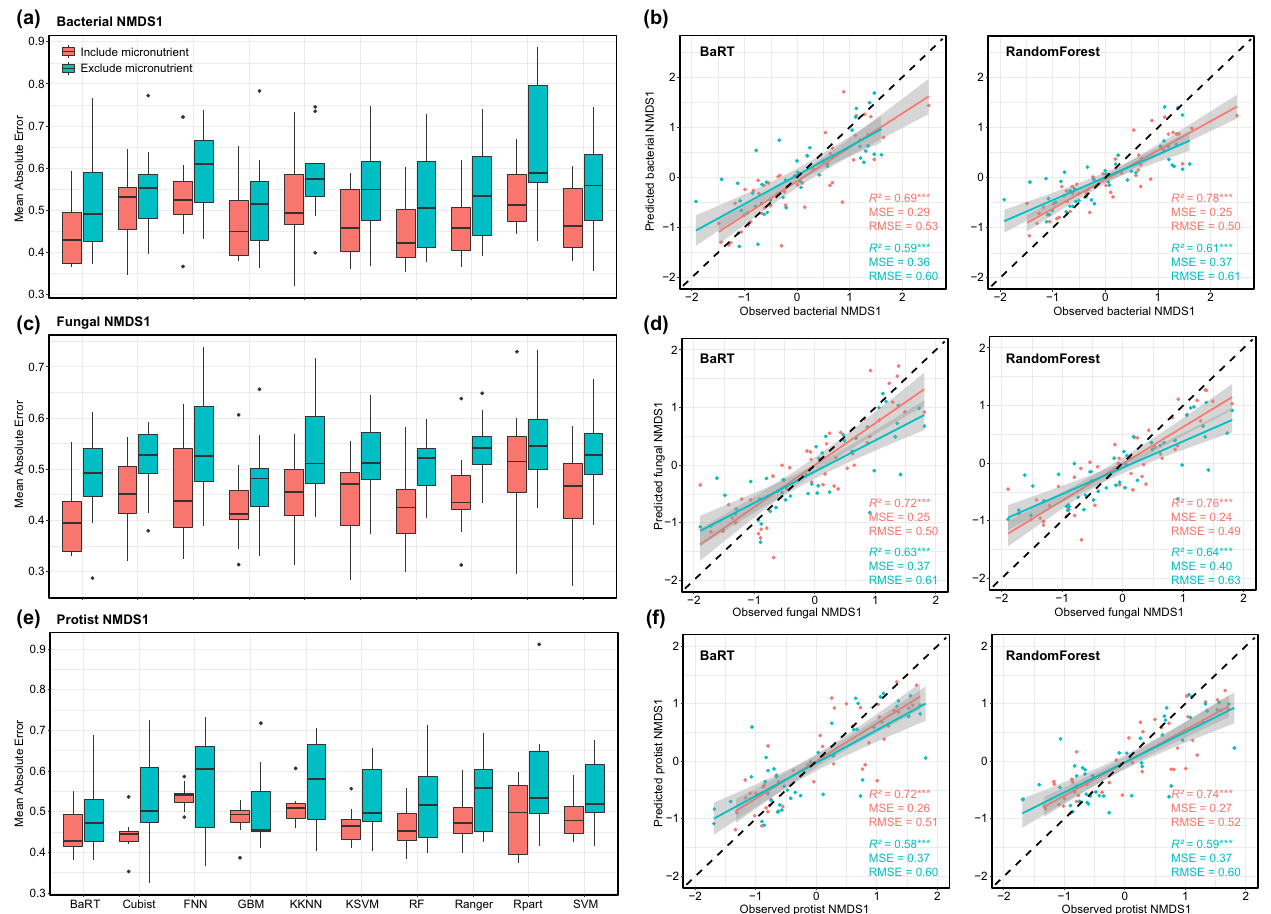
Fig. 5 Comparison of prediction errors of different machine learning algorithms for the structure of bacterial, fungal and protistan communities. Machine learning algorithms include Bagged Regression Tree (BaRT), Cubist, Fast Nearest Neighbor (FNN), Gradient Boosting Machines (GBM), Weighted k-Nearest Neighbor (KKNN), Kernel Support Vector Machine (KSVM), Random Forest (RF), Ranger, Rpart and Support Vector Machine (SVM), showing bacterial ( a ), fungal ( c ), and protistan communities ( e ). The center line of boxplot represents the median of data. The boxplot bounds the interquartile range (IQR) divided by the median, and whiskers extend to a maximum of 1.5 times the IQR beyond the box. Other observed data points outside the boundary of the whiskers are plotted as outliers, shown a dot. Predicted vs. observed the structure of bacterial ( b ), fungal ( d ) and protistan ( f ) communities of test dataset derived from bagged regression tree (BaRT) and random forest (RF). R 2 , coef fi cient of determination; MSE, mean squared error; RMSE, root mean squared error. The signi fi cance of statistical test was conducted by BaRT and RandomForest regression models. * p < 0.05, ** p < 0.01, and *** p < fungi, the composition of protists is dominated by consumers and is found to be jointly structured by climate, soil physicochemical properties, macronutrients, micronutrients and its prey 20,34 .